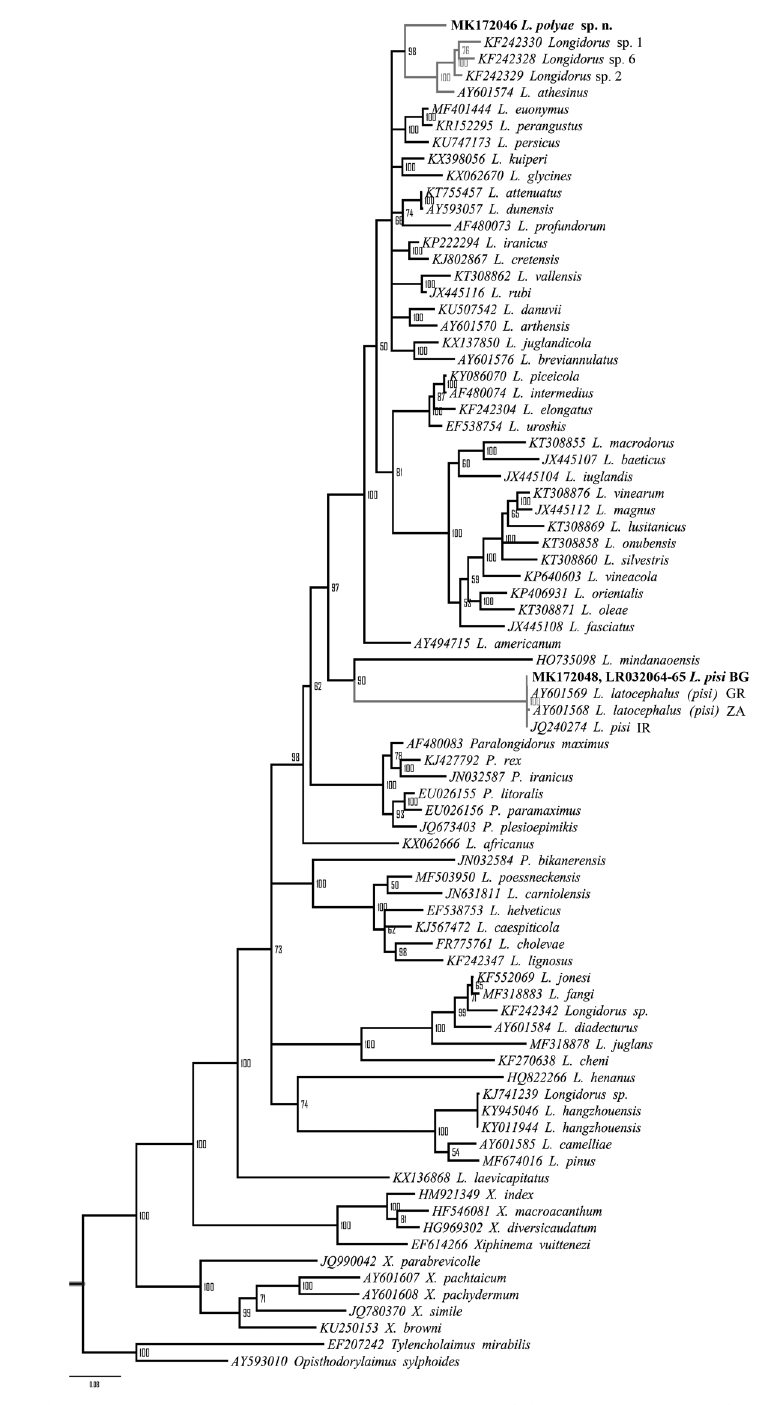
Figure 9. Phylogenetic tree using D2-D3 expansion segments of the 28S rRNA gene inferred from a Bayesian analysis with GTR+I+G model. Numbers represent the Bayesian posterior